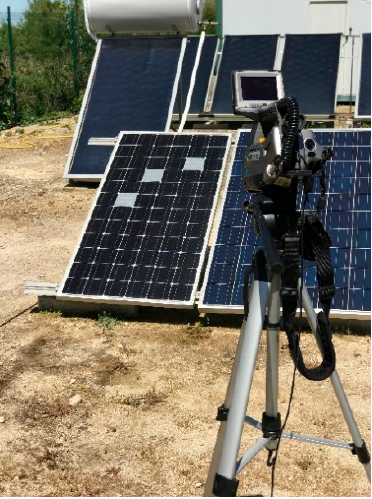
Figure 3. Position of the thermal camera in front of the covered PV cells E-3, C-4, and B-6.